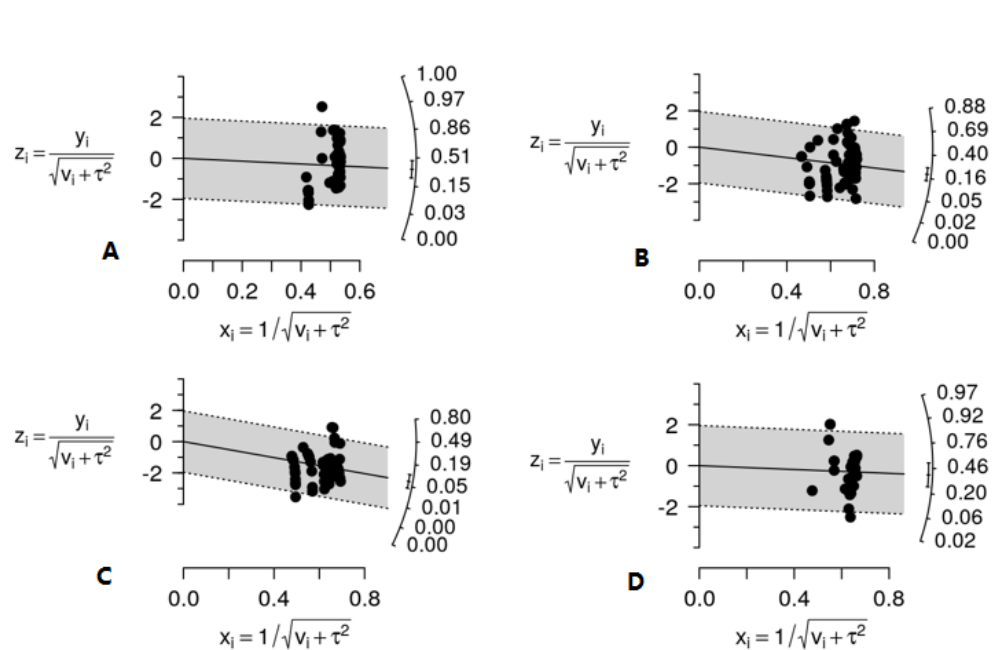
Figure 1. Galbraith plots of the meta-analyses of the incidence of the four pathogens in poultry meat surveyed at the end-processing stage and at retail establishments in Europe; Campylobacter spp. overall prevalence 33.3%; 95% CI: 22.3–46.4% ( A ); L. monocytogenes overall prevalence 19.3%; 95% CI: 14.4–25.3% ( B ); Salmonella spp. overall prevalence 7.10%; 95% CI: 4.60–10.8% ( C ); S. aureus overall prevalence 38.5%; 95% CI: 25.4–53.4% ( D ).For each observation i, y i denotes the logit-transformed incidence; v i the sampling variance; τ 2 the between-study variance; x i the incidence value’s precision; and z i